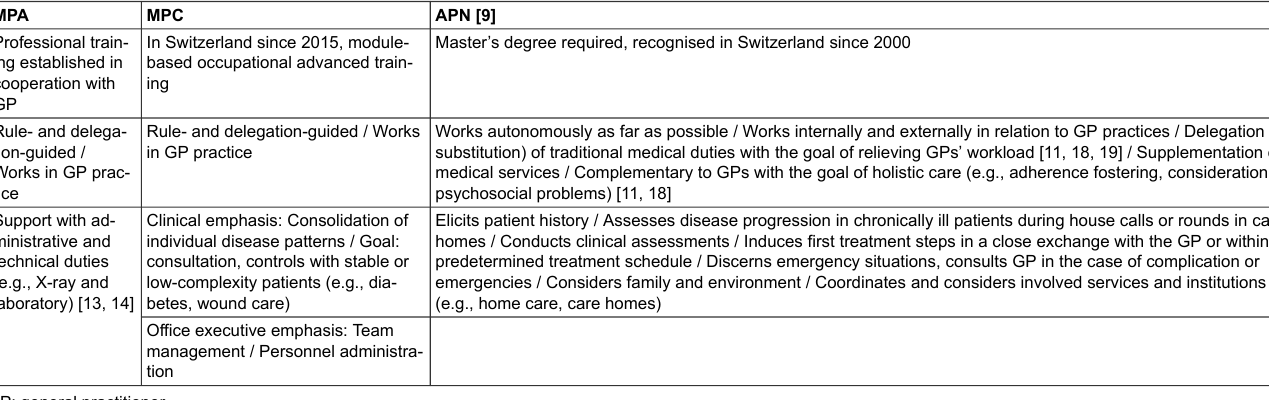
Table 1: Occupational profiles: medical practice assistant (MPA), medical practice coordinator (MPC), advanced practice nurse